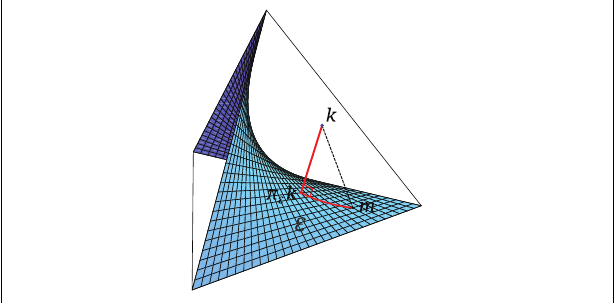
FIGURE 2 | Illustration of the Pythagoras theorem for projections